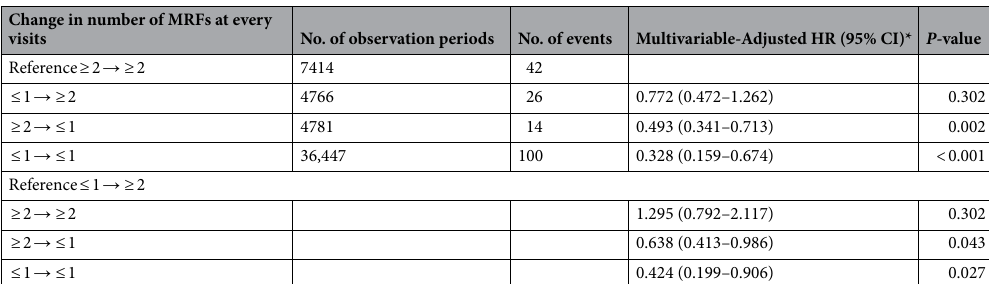
Table 4. Reduction of AF risk according to the change in number of modifiable risk factor. HR, hazard ratio; CI, confidence interval. *Multivariable adjustment was for sex, area and the time-varying assessment of age, systolic blood pressure, chronic kidney disease, cardiovascular disease, HbA1c and total cholesterol.